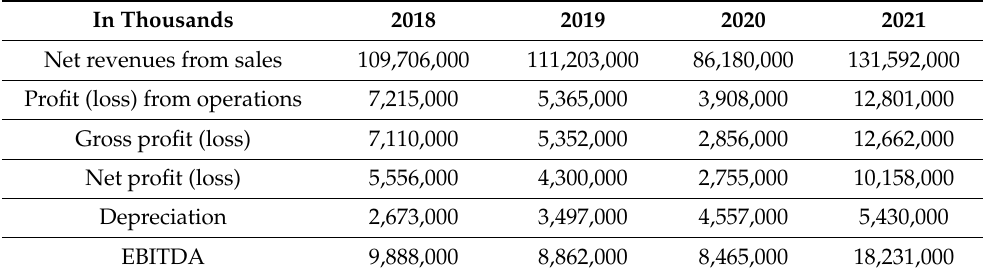
Table 7. Summary of economic data of PKN Orlen for 2018–2021 (in PLN). In